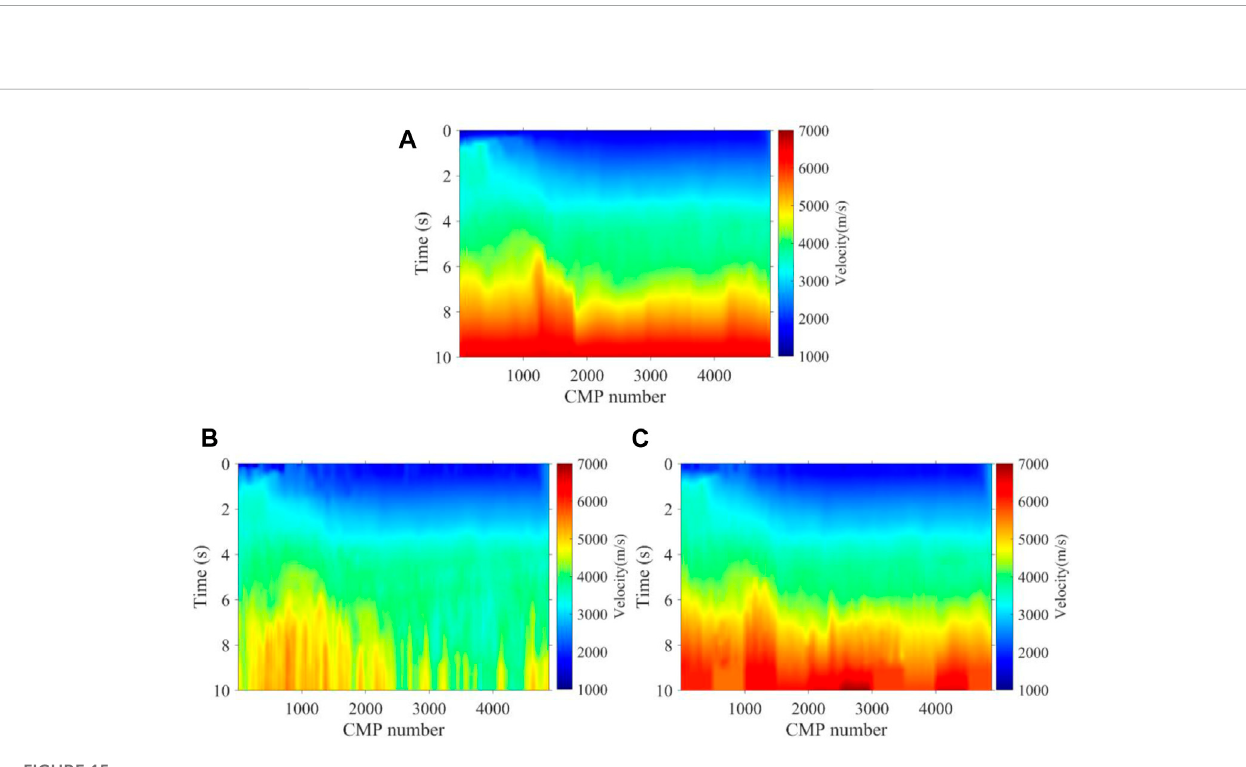
Frontiers in Earth